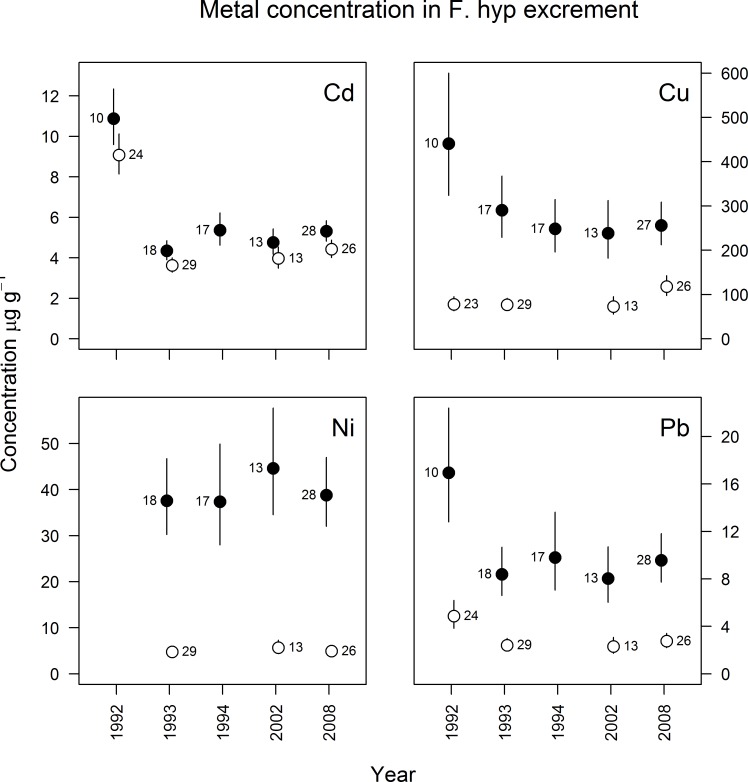
Metal concentration (μg g-1 dw, geometric mean ± 95% confidence limit) in excrement of pied flycatcher (Ficedula hypoleuca) nestlingssampled between 1992 and 2008 from polluted (black dots, ≤ 2 km from the smelter) and reference areas (open dots, > 4 km from the smelter). Numbers denote sample size.